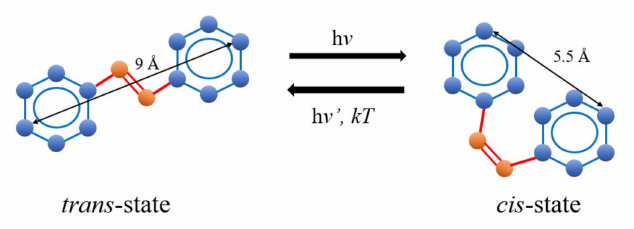
Figure 1. The photoisomerization process of